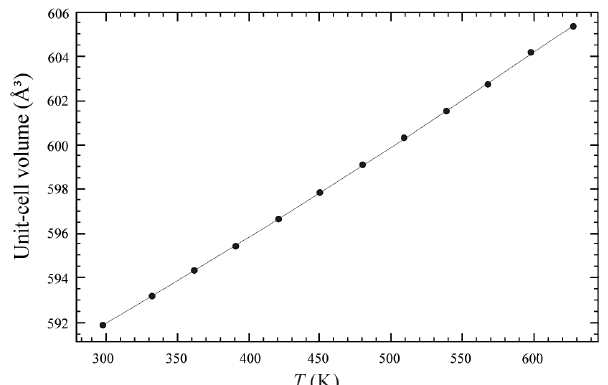
Figure 4. Evolution of the unit-cell volume with temperature of bur- bankite. Data were fitted with a Berman-type EoS (solid line).